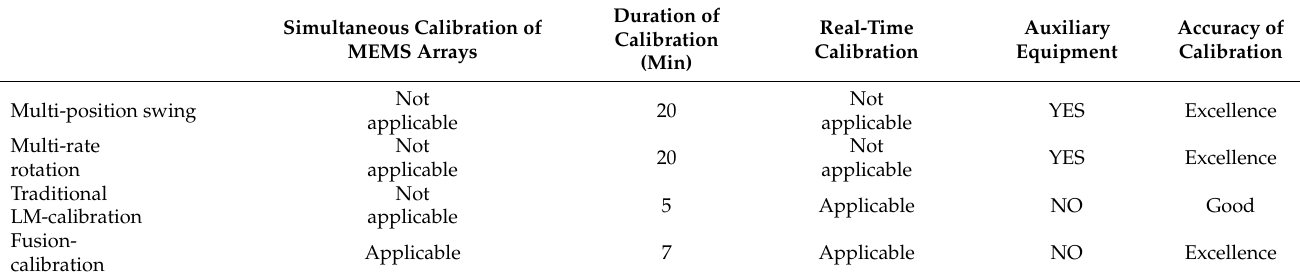
Table 1. Comparison of fusion-calibration algorithms with conventional algorithms.